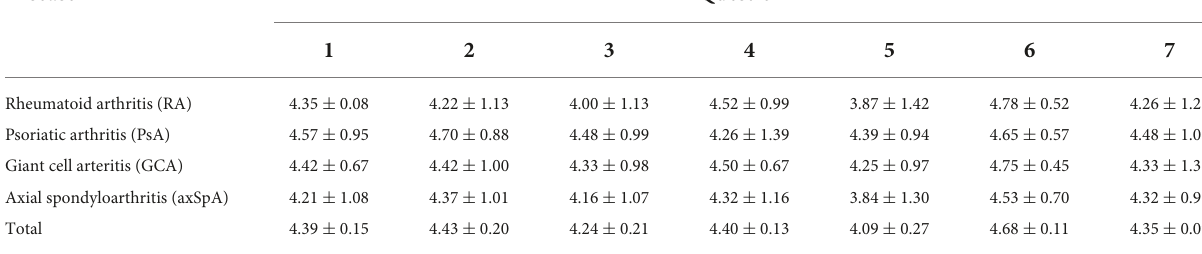
TABLE 2 Results of the survey.